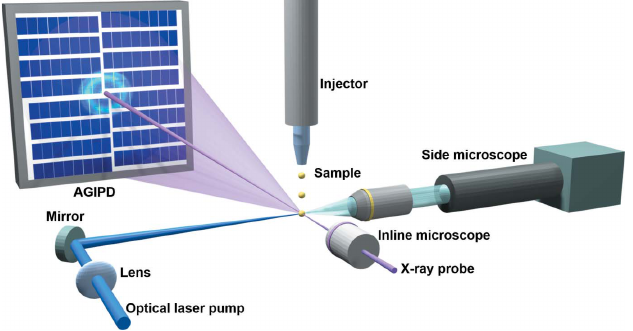
Figure 2 Schematic of a pump–probe experimental setup at IRU of the SPB/SFX